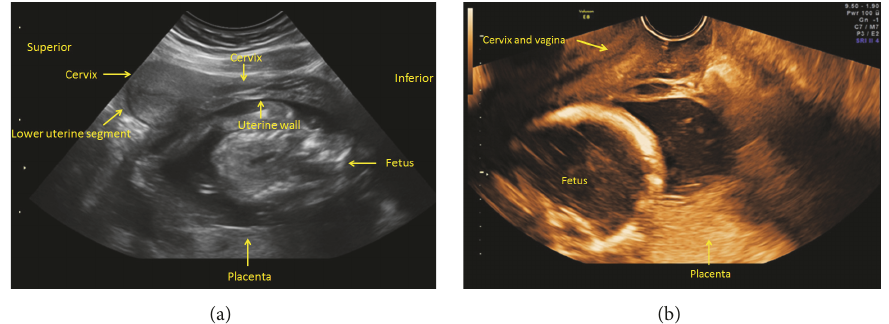
Figure 2: Re-evaluation of the ultrasound images obtained at 19 weeks. Transabdominal (a) and endovaginal (b) ultrasound images showing the anteriorly located and stretched cervix and lower uterine